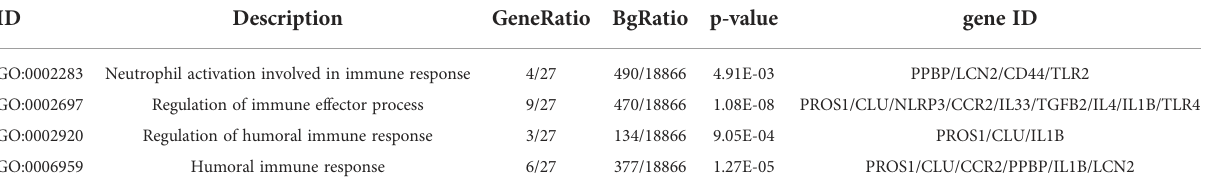
TABLE 4 The immune-related pathways in the term of biological process. ID